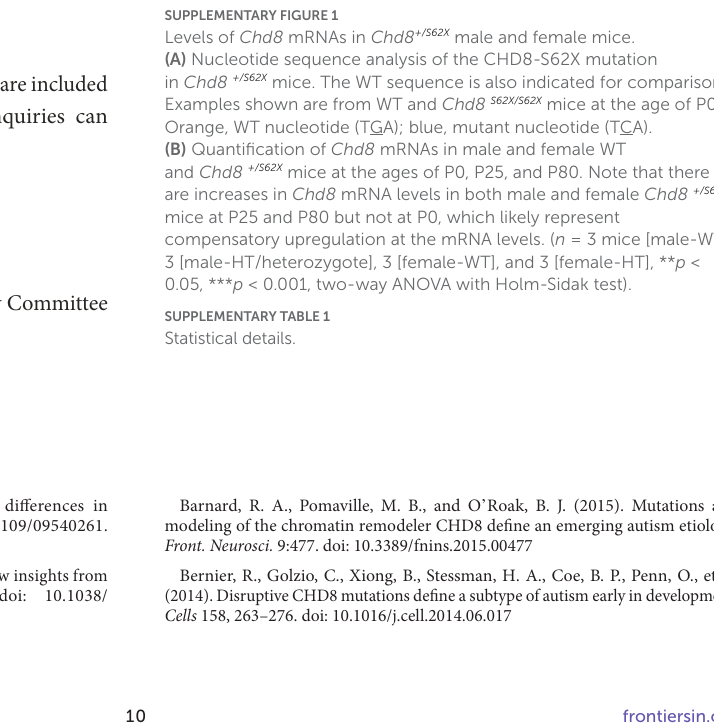
SUPPLEMENTARY FIGURE 1 Levels of Chd8 mRNAs in Chd8 +/S62X male and female mice. (A) Nucleotide sequence analysis of the CHD8-S62X mutation in Chd8 +/S62X mice. The WT sequence is also indicated for